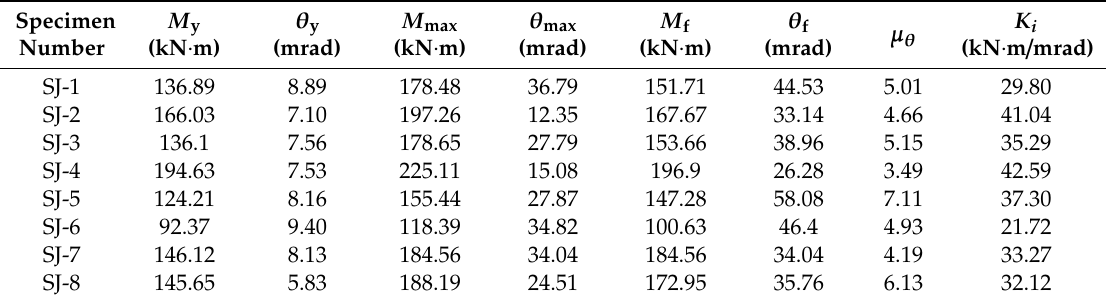
Figure 15. Determination of the key parameters in the M - θ relationship of joints. Table 4. of the main results.